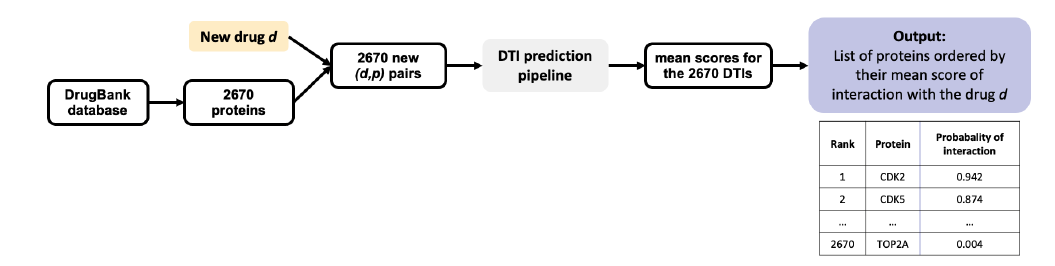
Figure 3. Flowchart of the target identification